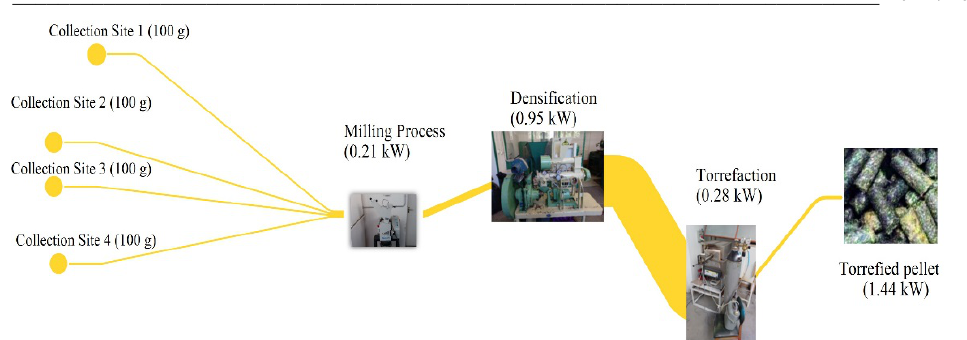
Fig. 1. The process flow diagram of the raw pine cones along with energy consumption.